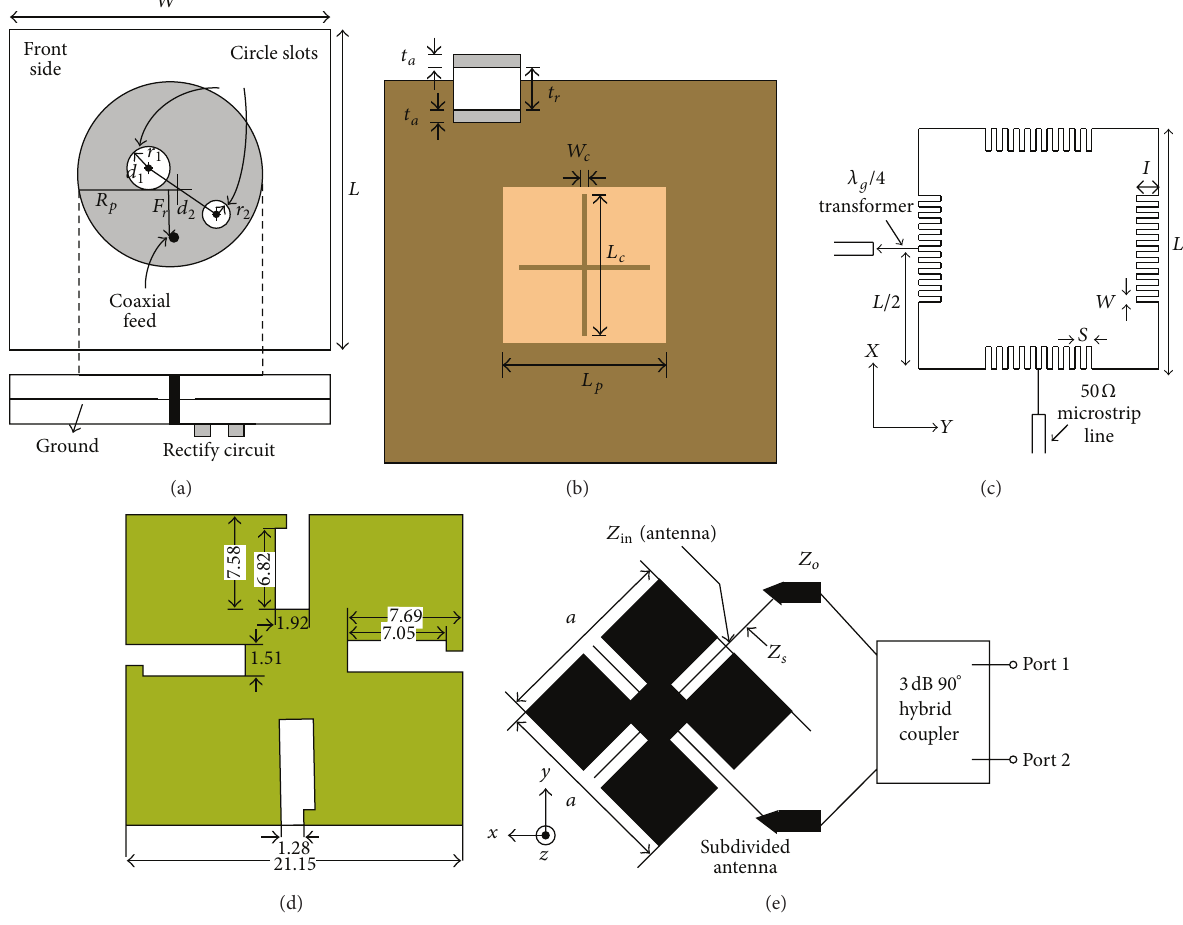
Figure 3: Various miniaturized antenna